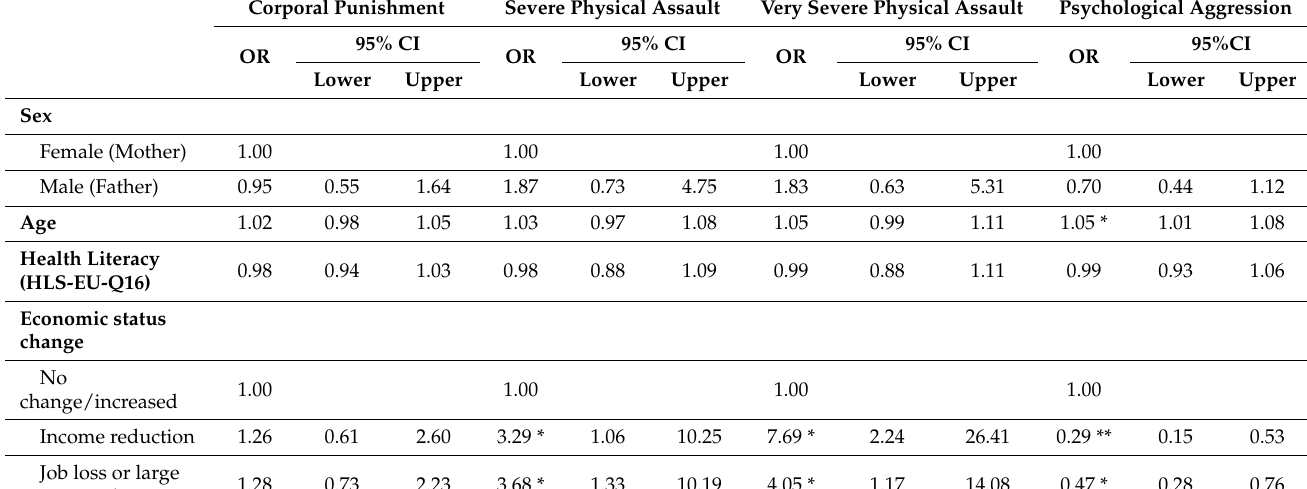
Table 3. Logistic regression analysis predicting child